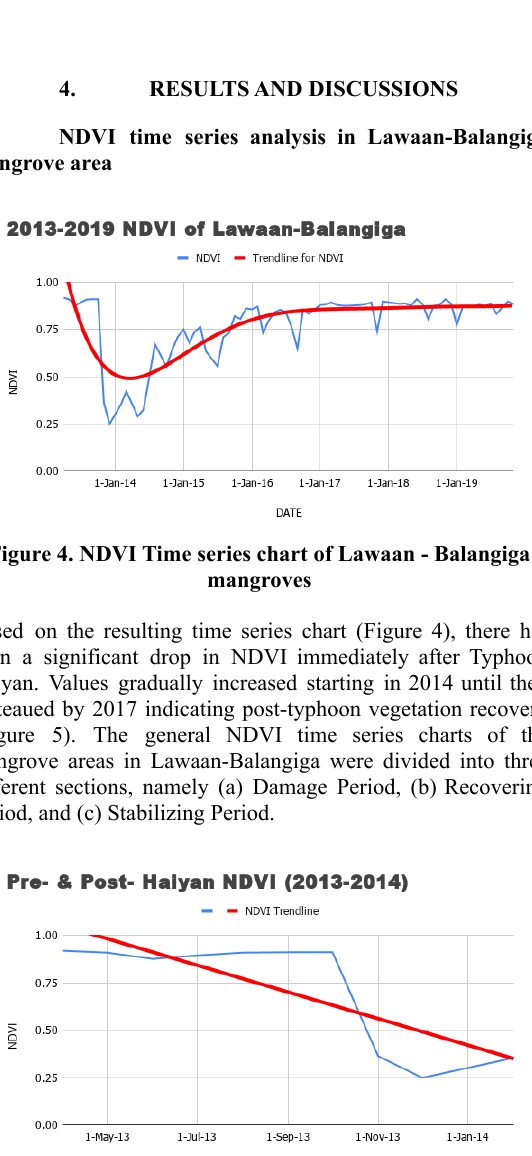
Figure 6. 2014 to Early 2017 NDVI Time Series Chart (Recovering Period)